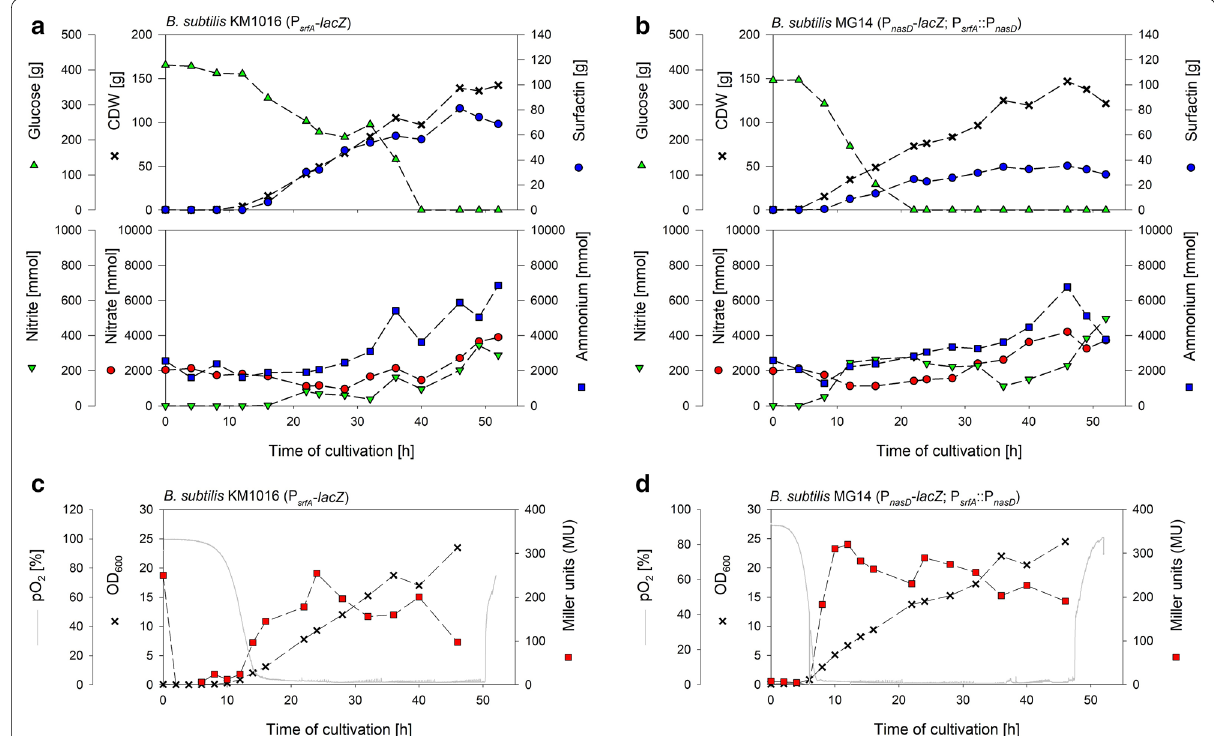
Fig. 4 Exemplary cultivation results of fed-batch bioreactor cultivations employing strains B. subtilis KM1016 (P srfA - lacZ ) ( a , c ) and B. subtilis MG14 (P srfA ::P nasD ; amyE ::[P nasD - lacZ, spcR ]) ( b , d ). Displayed are absolute values of cell dry weight (CDW), glucose, surfactin (all [g]), nitrate, nitrite and ammonium (all [mmol]) ( a , b ), as well as the time course of OD 600 , Miller units as determined by the Miller Assay to determine the expression of P srfA and P nasD , and pO 2 [%] ( c , d